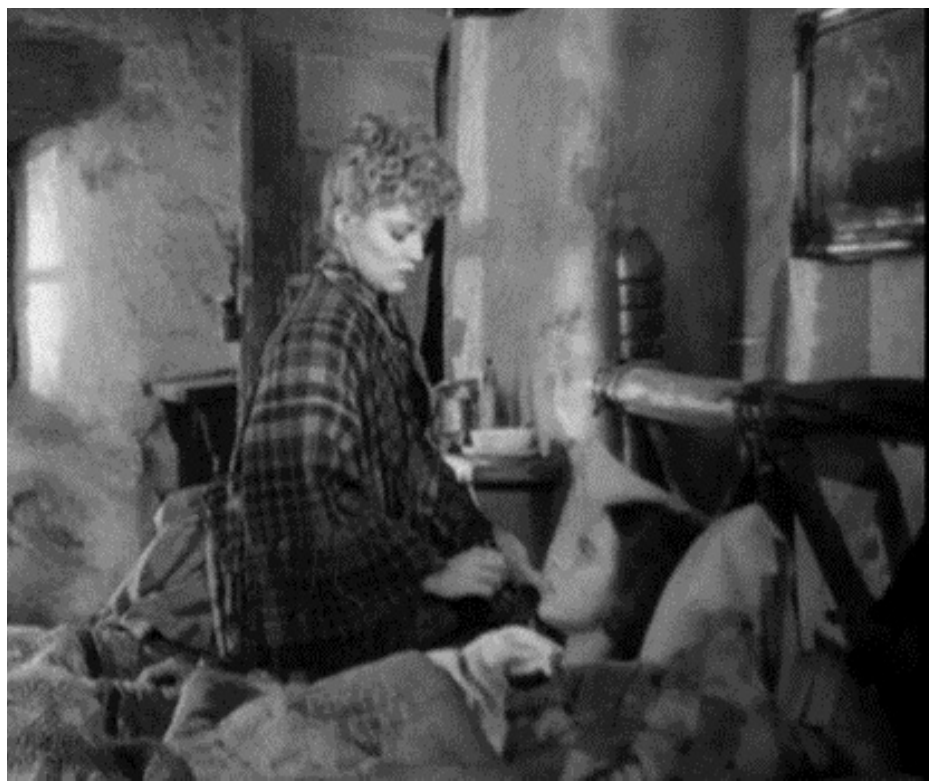
Figure 8: After childbirth, Dallas braids Lucy Mallory’s hair and cares for the baby. Mallory sees Dallas for the first time, a revelation of Dallas herself and a clear film evocation of the prostitute as Christ